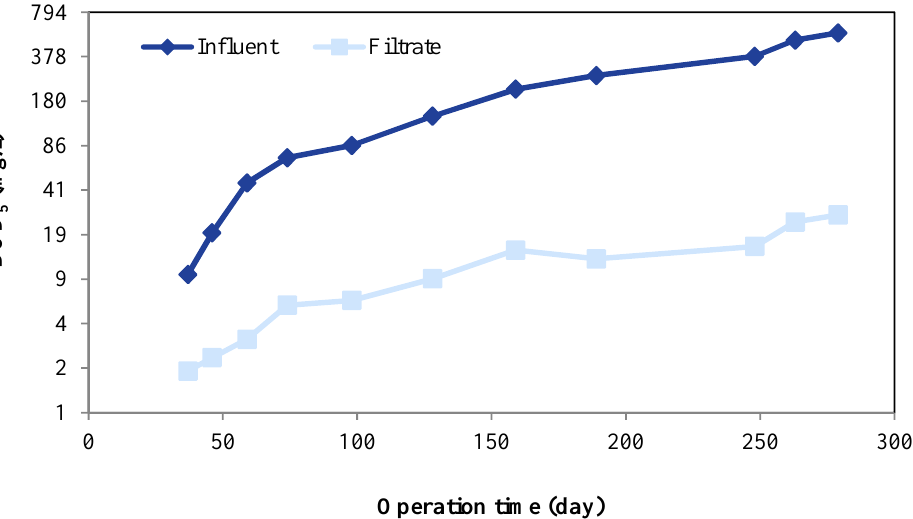
Figure 2. Feed and filtrate biochemical oxygen demand (BOD5) during bioreactor operation